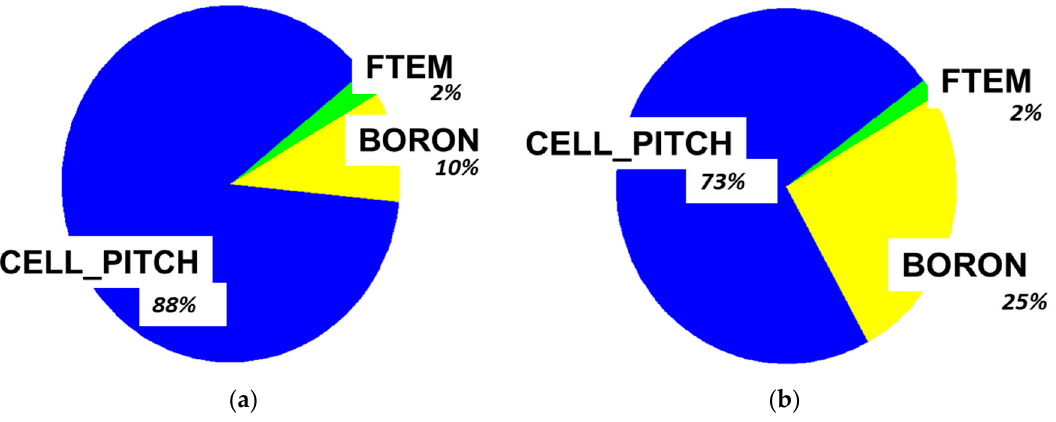
Figure 16. Pie-plot—total sensitivity Index for k ∞ : ( a ) hexagonal UOX CELL; ( b ) squared UOX CELL. PWR UOX AND UGD